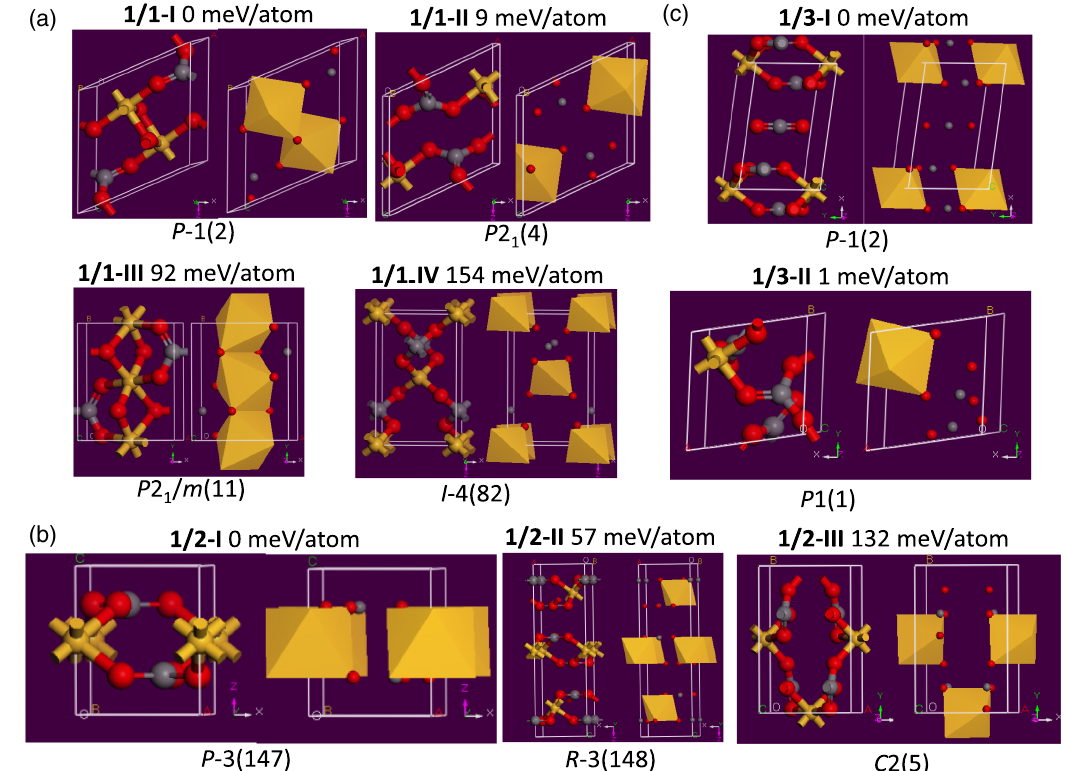
FIG. 2 (color online). Low-enthalpy structures of the (a) ð SiO 2 Þ 1 ð CO 2 Þ 1 , (b) ð SiO 2 Þ 1 ð CO 2 Þ 2 , and (c) ð SiO 2 Þ 1 ð CO 2 Þ 3 compounds,